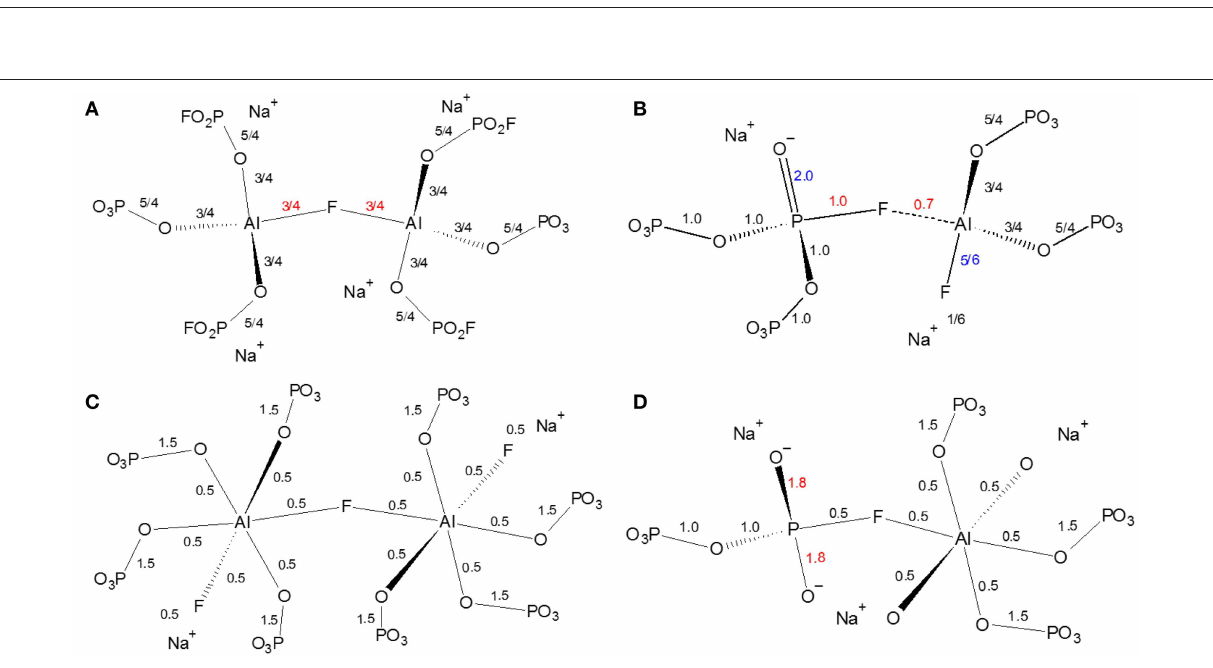
Frontiers in Materials |